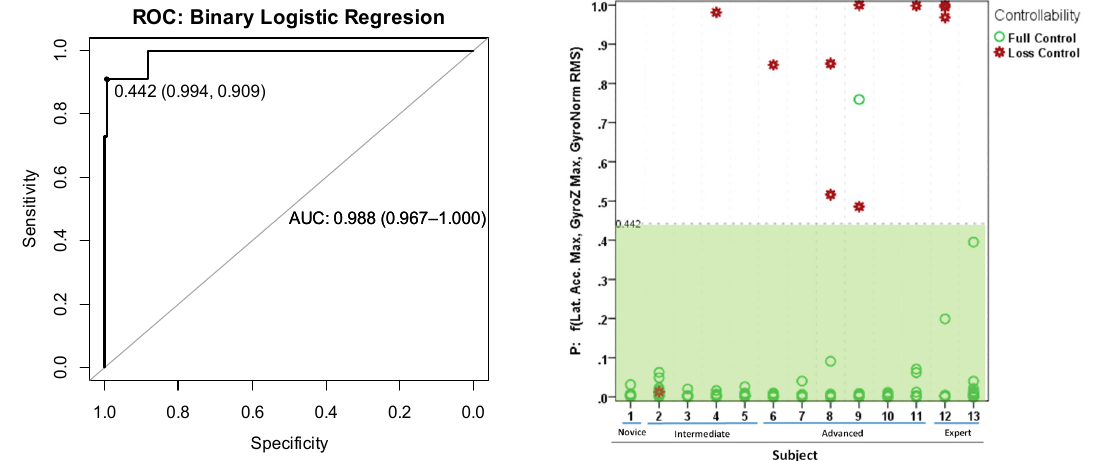
Figure 7. Model-1: ROC and scatter plot of loss of control probability by subject for the 165 braking trials.